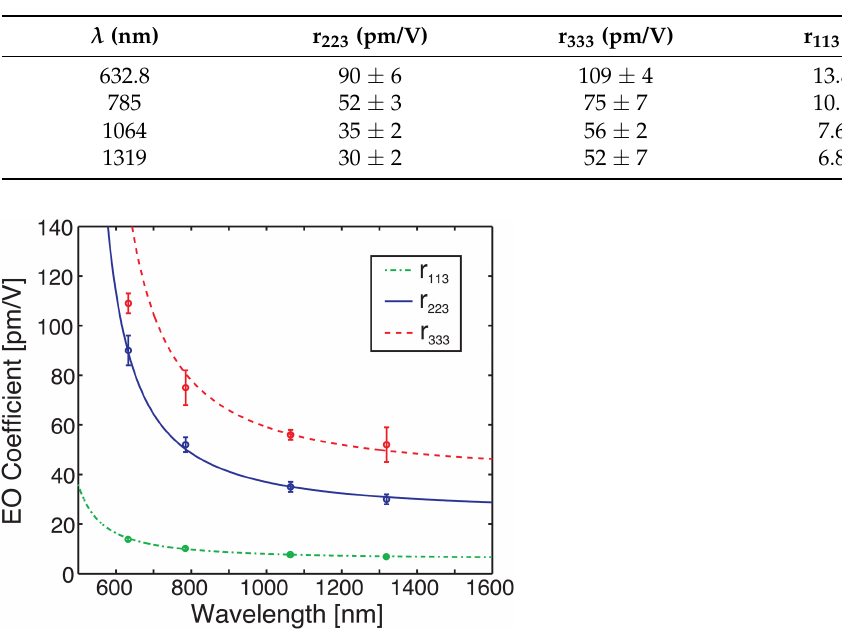
Table 17. Linear electro-optic coefficients of OH1 [96].